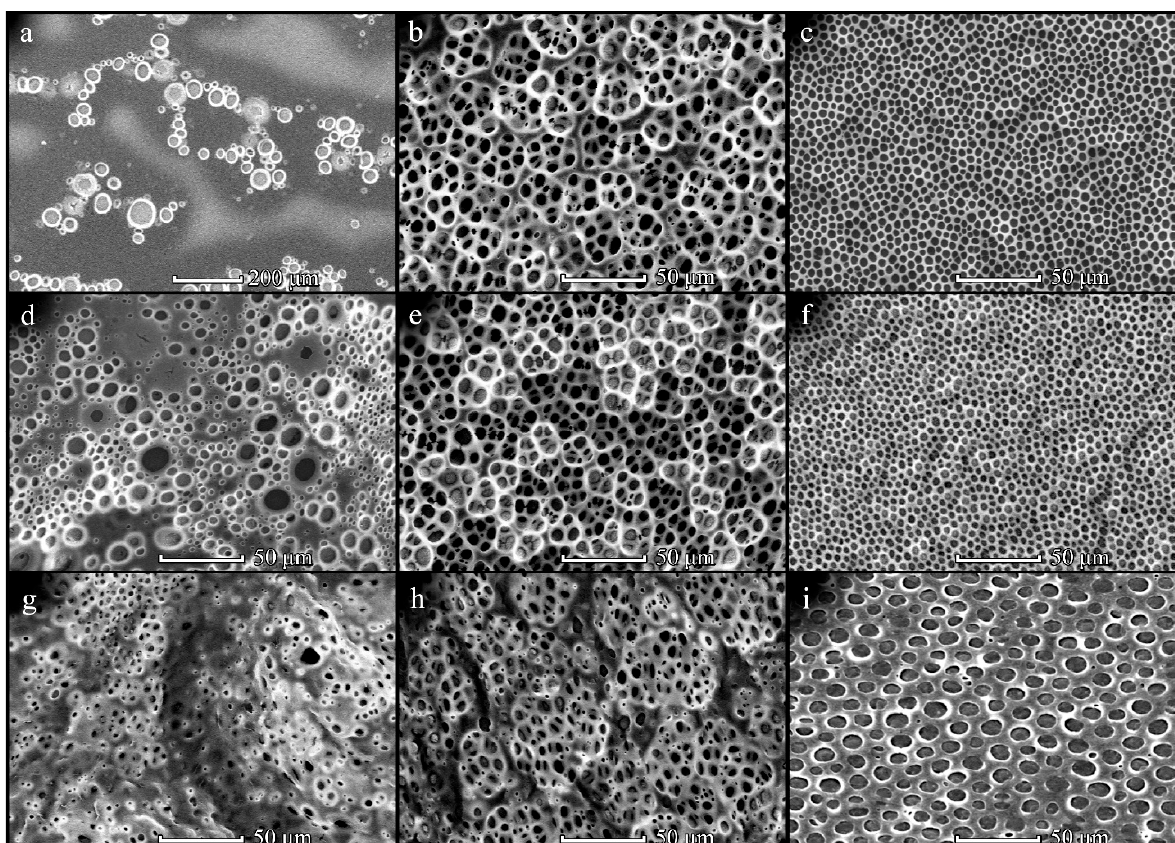
Figure 1. SEM-images of the PHB350 films obtained from solution with concentrations of 5 ( a , d , g ), 20 ( b , e , h ) and 40 ( c , f , i ) mg/mL upon L = 1 cm. The solution volume is 150 ( a – c ), 300 ( d – f ) and 450 ( g – i ) μ L.